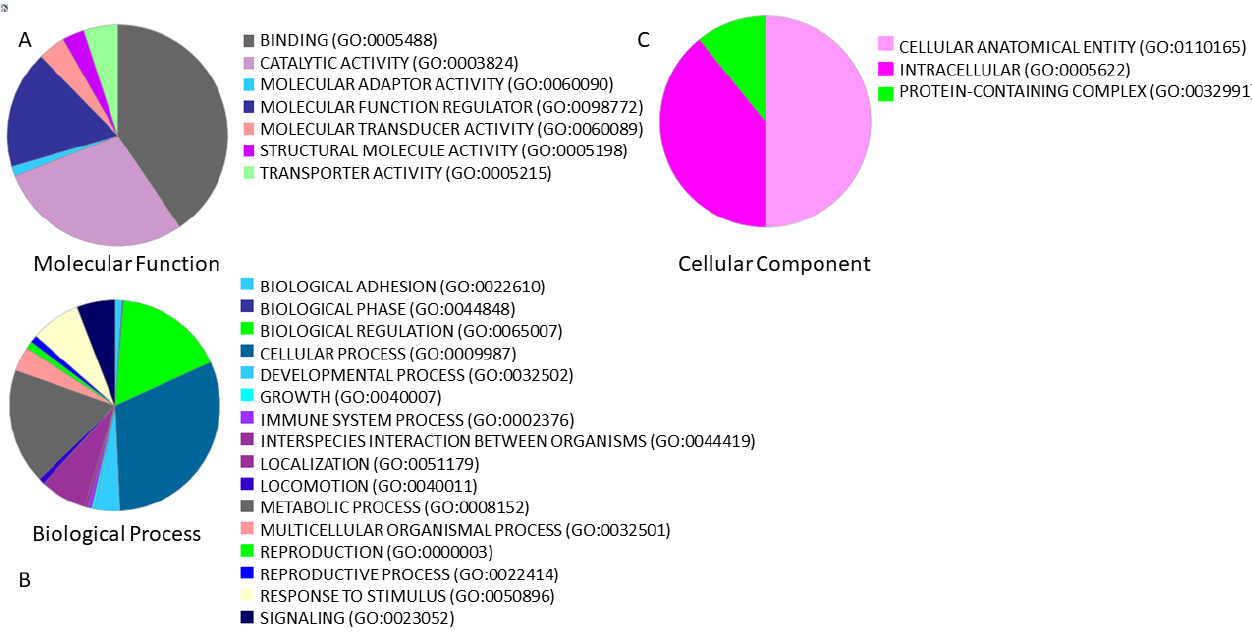
Figure 2. Functional classification using PANTHER of 349 lncRNAs associated with male infertility and interacting with miR-125a-5p , miR-125b-5p , miR-936 and miR-204-5p . Overall, we found 349 unique lncRNAs. The percentage of lncRNAs involved in ( A ) molecular function, ( B ) biological processes, and ( C ) cellular component is represented by a pie chart.